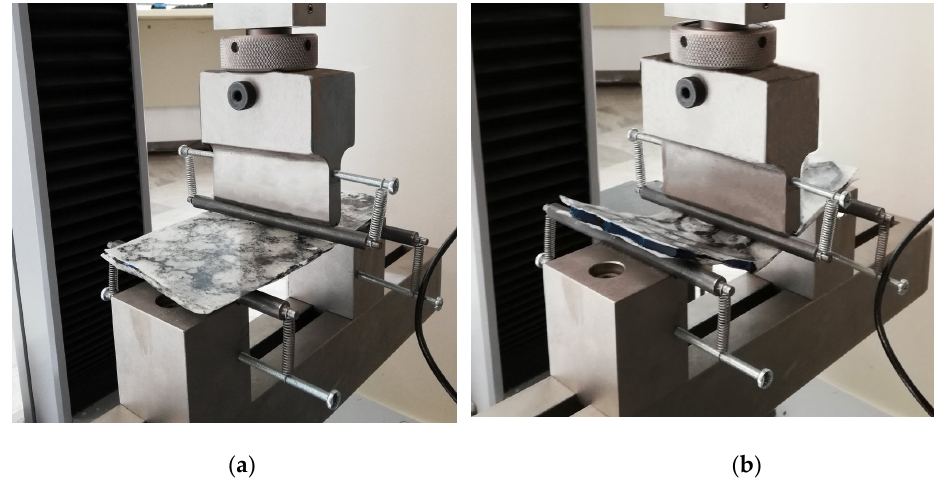
Figure 6. A 3-point bending test on starch-based sandwich structures ( a ) at zero deformation with no bending load applied and ( b ) maximum deformation under ultimate bending